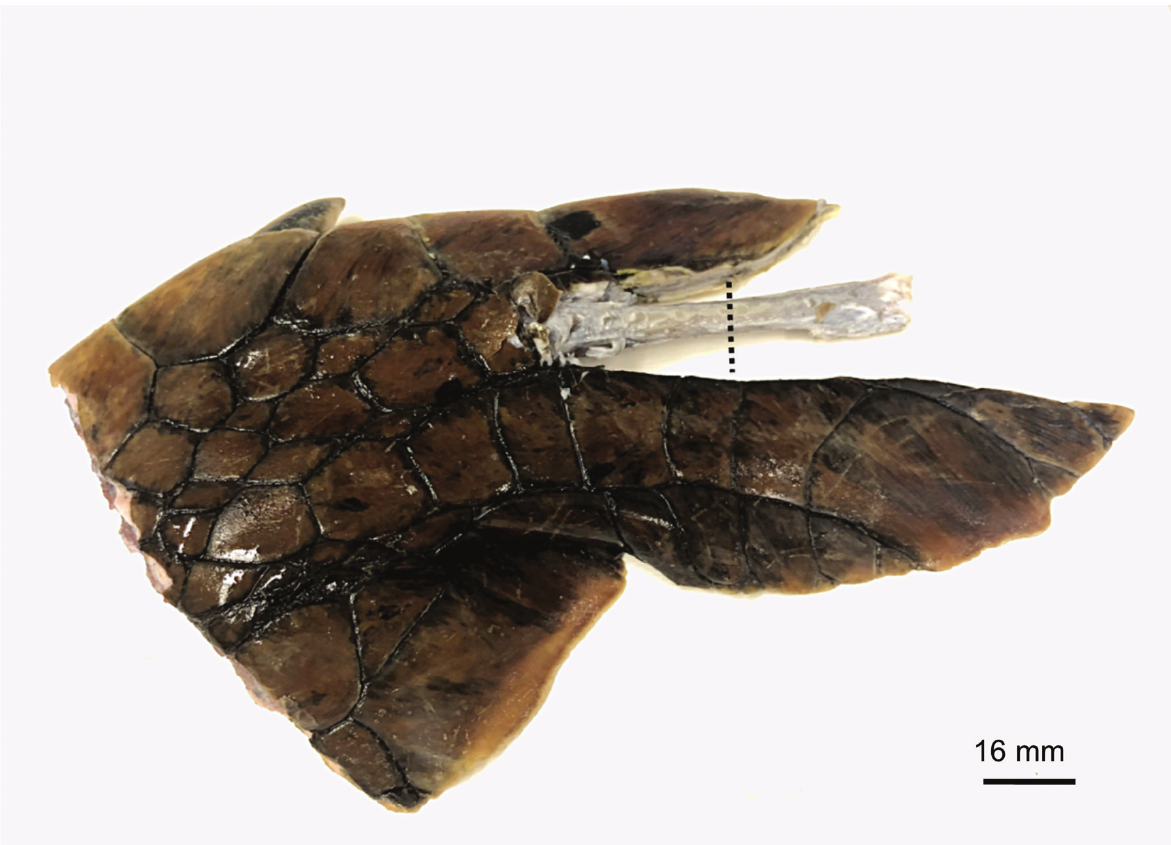
Figure 1. Dorsal view of anterior flipper of C. caretta. The soft tissues have been partially removed from the third finger to expose the phalanx bone. Dotted line shows the level of sectioning, perpendicular to the long axis of phalanx, from which bone sections were